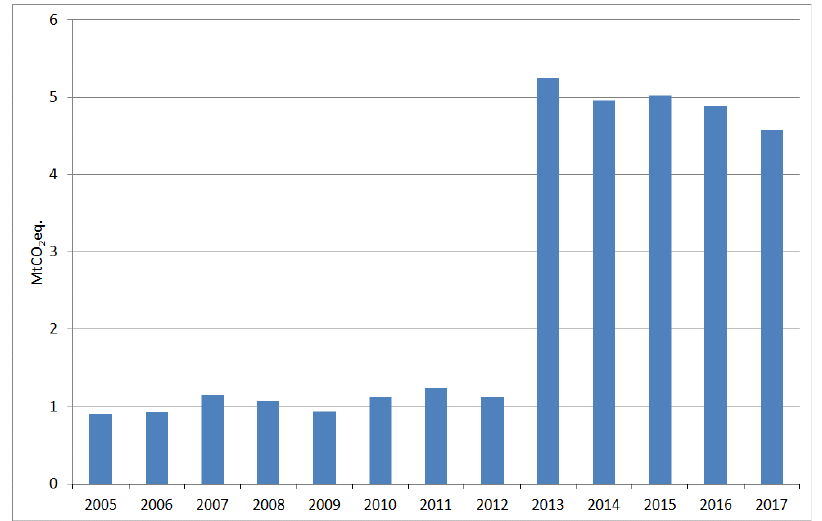
Figure 11. Overall greenhouse gas emissions of nitric acid in the EU EUTL data. Source: Activity 38 (nitric acid) [25].